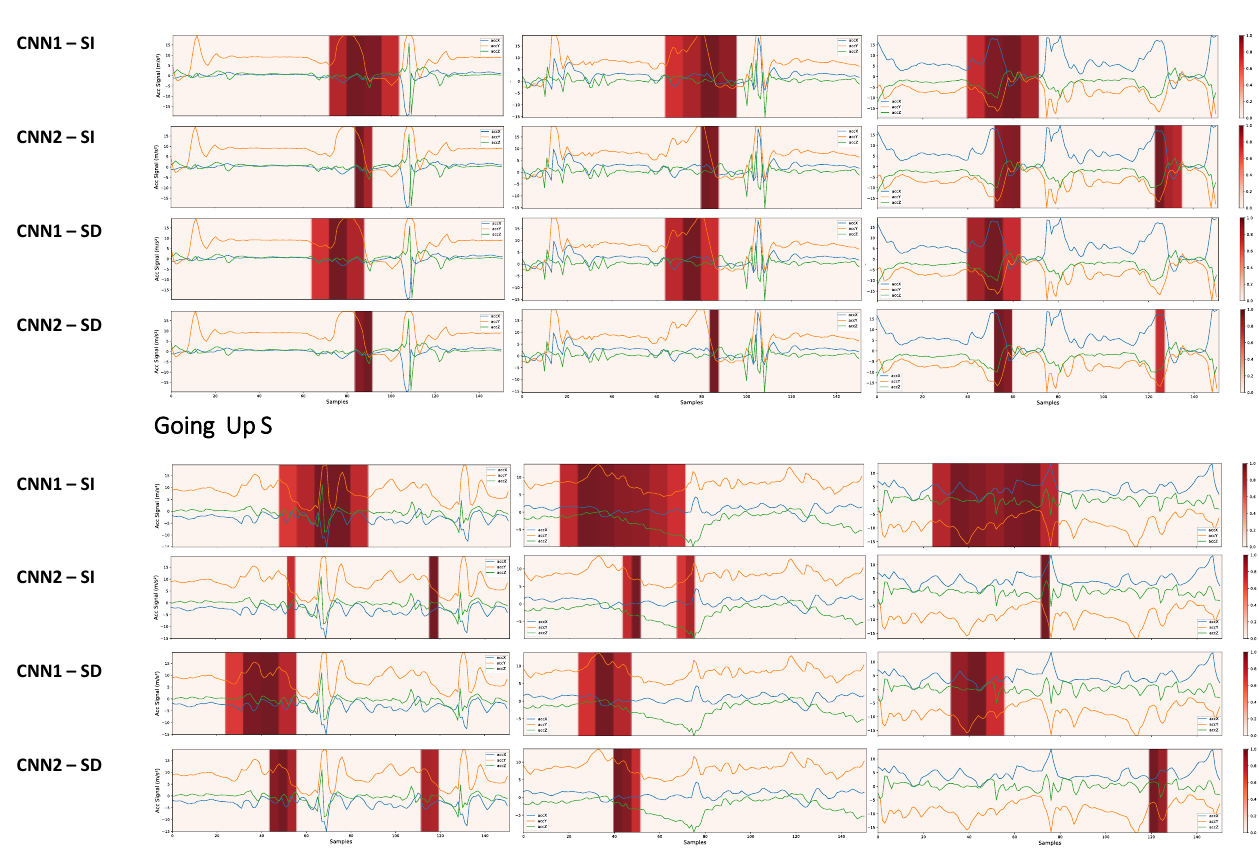
Figure 16. Most important portions for decision making in the CNN1 and CNN2 networks with the SD and SI strategies, for samples of the Jumping and GoingUpS activities. To obtain the heatmaps, a threshold of 0.7 was considered in the grad-CAM result to make the critical regions more evident.